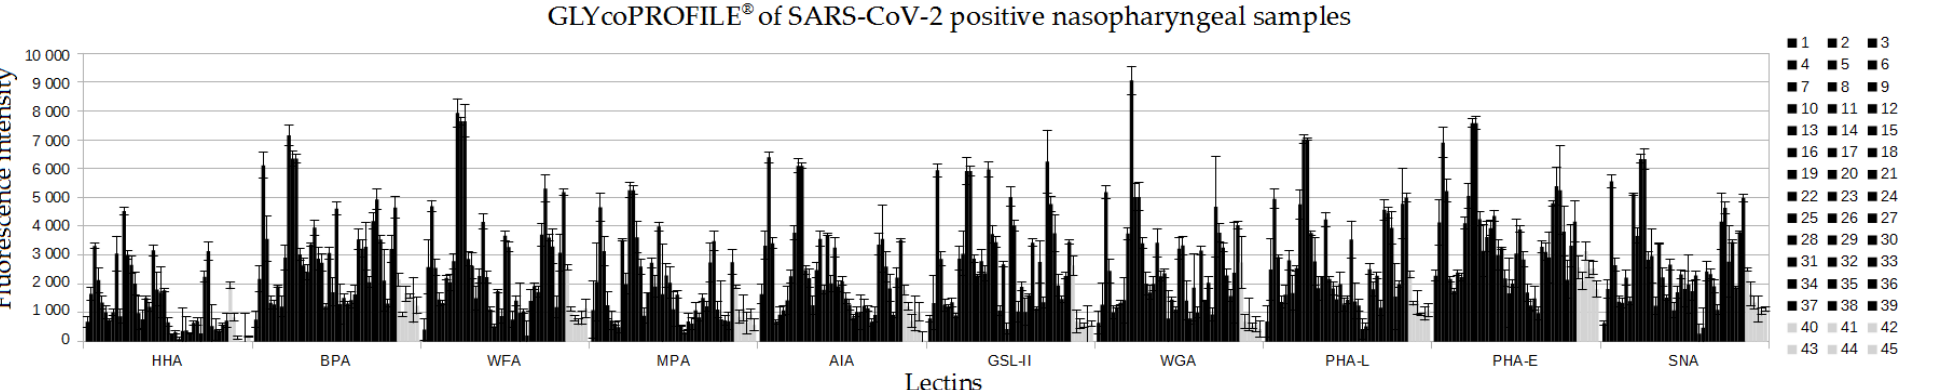
Figure 3. GLYcoPROFILE ® raw data of SARS-CoV-2-positive (N°1–39 in black) and -negative (N°40–45 in grey) nasopharyngeal samples on a panel of 10 lectins. Non-diluted samples were screened against selected lectins, previously adsorbed on LEctPROFILE ® plate, and revealed with anti-SARS-CoV-2 antibodies (1/100).